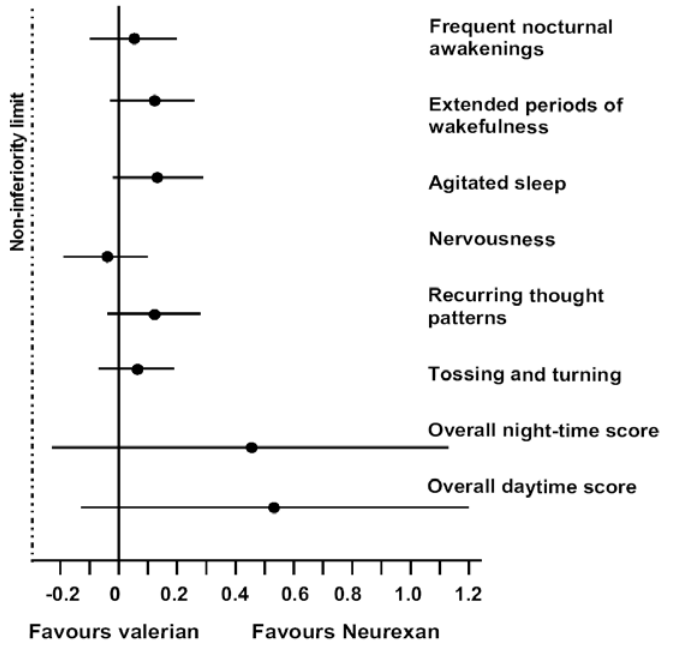
FIGURE 2 . Mean differences and 95% confidence intervals for overall night- time and daytime therapeutic effectiveness between the two treatments, and for the components of the night-time score. Positive values favor Neurexan. The dotted line indicates the border for noninferiority of Neurexan to valerian